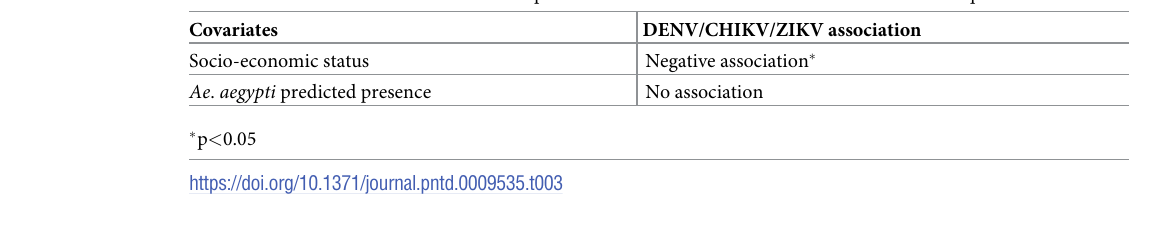
Table 3. Association of DENV, CHIKV, ZIKV cases with socio-economic status, and Ae aegypti habitat suitability. The table shows the result of the GLM. The power of the model was > 0.8 and the model VIF was equal to